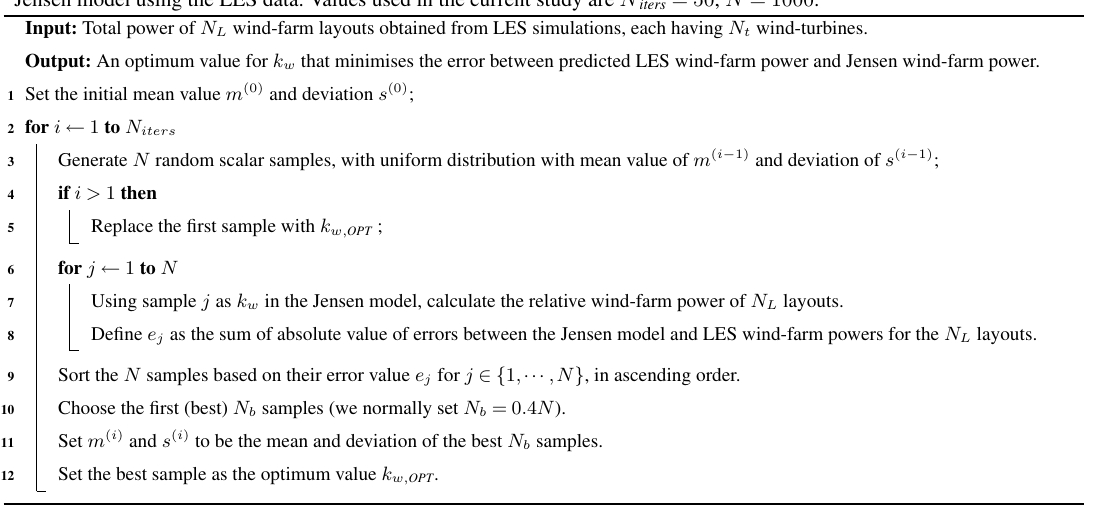
Algorithm 3: The outline of the cross–entropy optimisation method for optimising the wake expansion coefficient in the Jensen model using the LES data. Values used in the current study are N iters = 50 , N = 1000 .